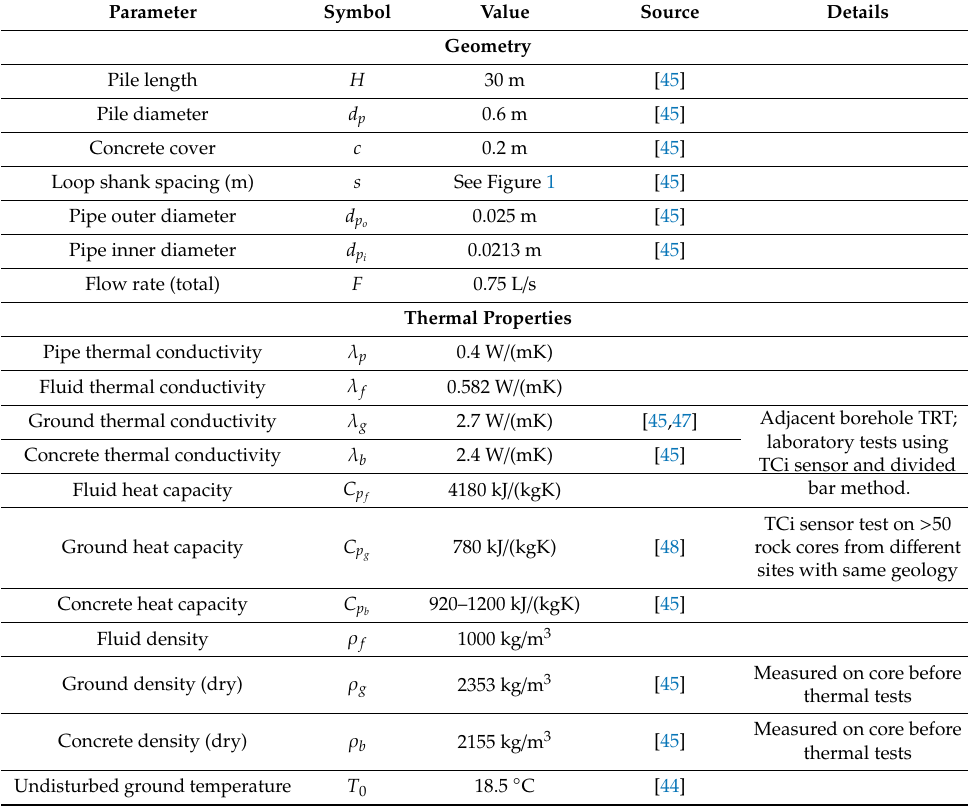
Figure 1. Pile geometry and detail of cross section. GHE: ground heat exchanger; HDPE: high density polyethylene. Table 1. Energy Pile Geometry and Properties.